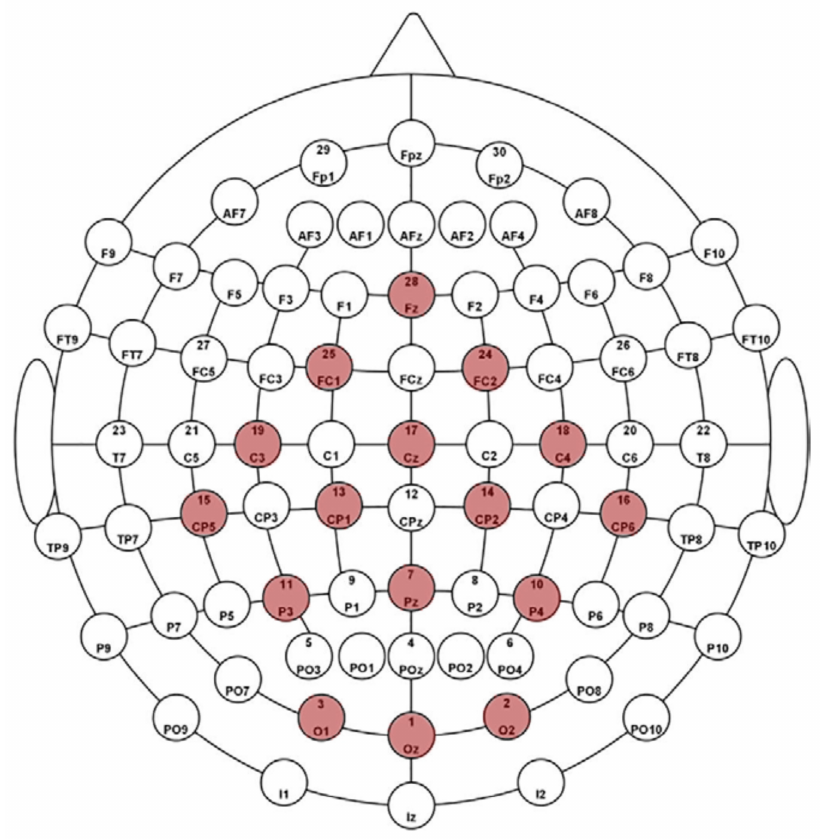
Figure 2. The representation of located EEG electrodes on the scalp [18]. For this reason, if the voice given to the person is heard by the person, it was accepted that they would hear a similar frequency and higher decibels, and the same sounds were not given to the person again. Likewise, for the sounds that the person cannot hear, sounds with the same frequency but lower decibels cannot be heard, so the sounds in this decibel are not given to the person again. The hearing test interface is shown in Figure 3. The person to be hearing the test was put on headphones and given a keyboard or mouse to indicate the sounds he heard. If “Random db” and “Random freq” sections are selected on the interface, the sounds will be given at random frequency and intensity. If not selected, sounds in sequential frequency and decibel values will be given in the form of a standard hearing test. In this study, it was thought that sounds with random frequency and decibel value would create a more pronounced stimulus in the brain. With the “Left Ear” option, the hearing test is performed only on the left ear, with the “Right Ear” option only on the right ear, and with the “Both of Ears” option, during which the two ears are tested sequentially, first the left ear and then the right ear. The test starts with the selected settings by clicking the “START TEST” button. In this study, the left and right ears were tested sequentially with random frequency and decibel values by choosing the “Both of Ears”, “Random db” and “Random freq”